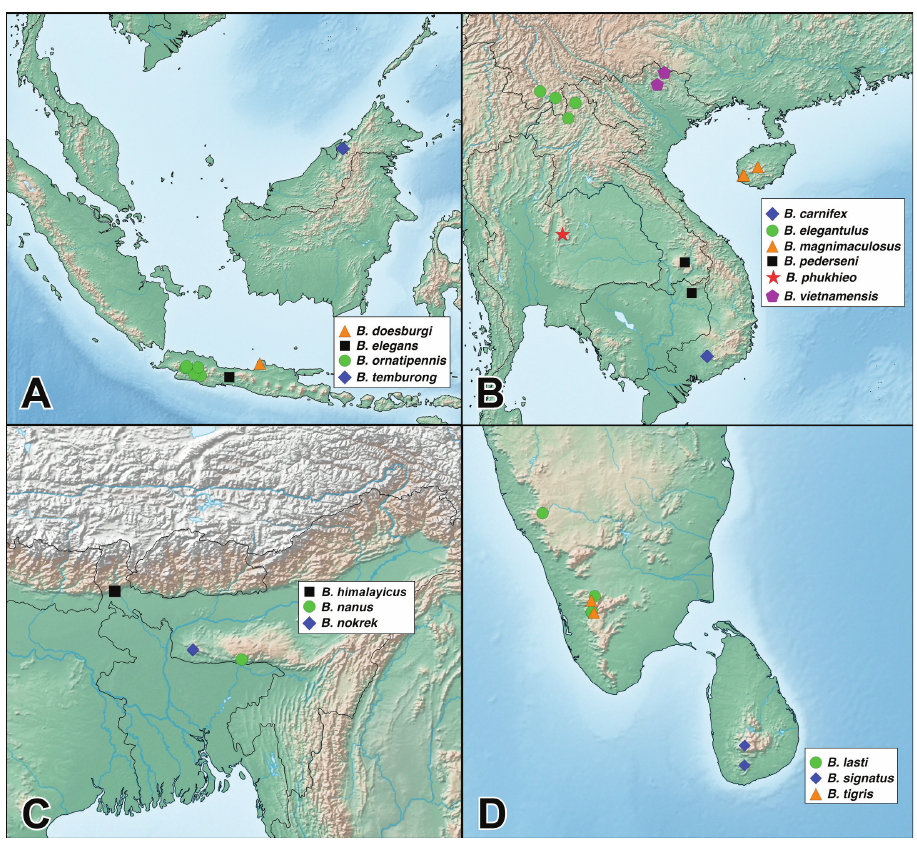
Figure 20. Distribution of: Bolitogyrus doesburgi (Scheerpeltz), B. elegans (Cameron), B. ornatipennis (Wendeler) and B. temburong Brunke ( A ); B. carnifex (Fauvel), B. elegantulus Yuan et al., B. magnimacu- losus Cai et al., B. pederseni Brunke, B. phukhieo Brunke and B. vietnamensis (Scheerpeltz) ( B ); B. hima- layicus Brunke, B. nanus Brunke and B. nokrek Brunke ( C ); B. lasti Rougemont, B. signatus (Cameron) and B. tigris Brunke ( D